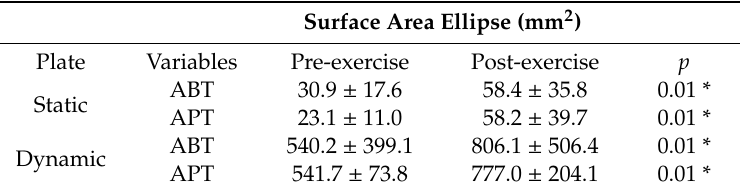
Table 5. Comparison of variations in surface area ellipses on a static and a dynamic plate with eyes closed before and after fatigue-inducing